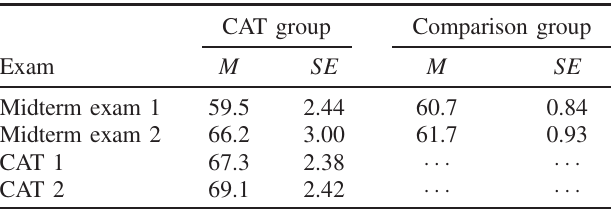
TABLE IV. Means and standard errors of the mean for scores on course exams and CATs. Note that the CAT group is N ¼ 25 , the comparison group N ¼ 259